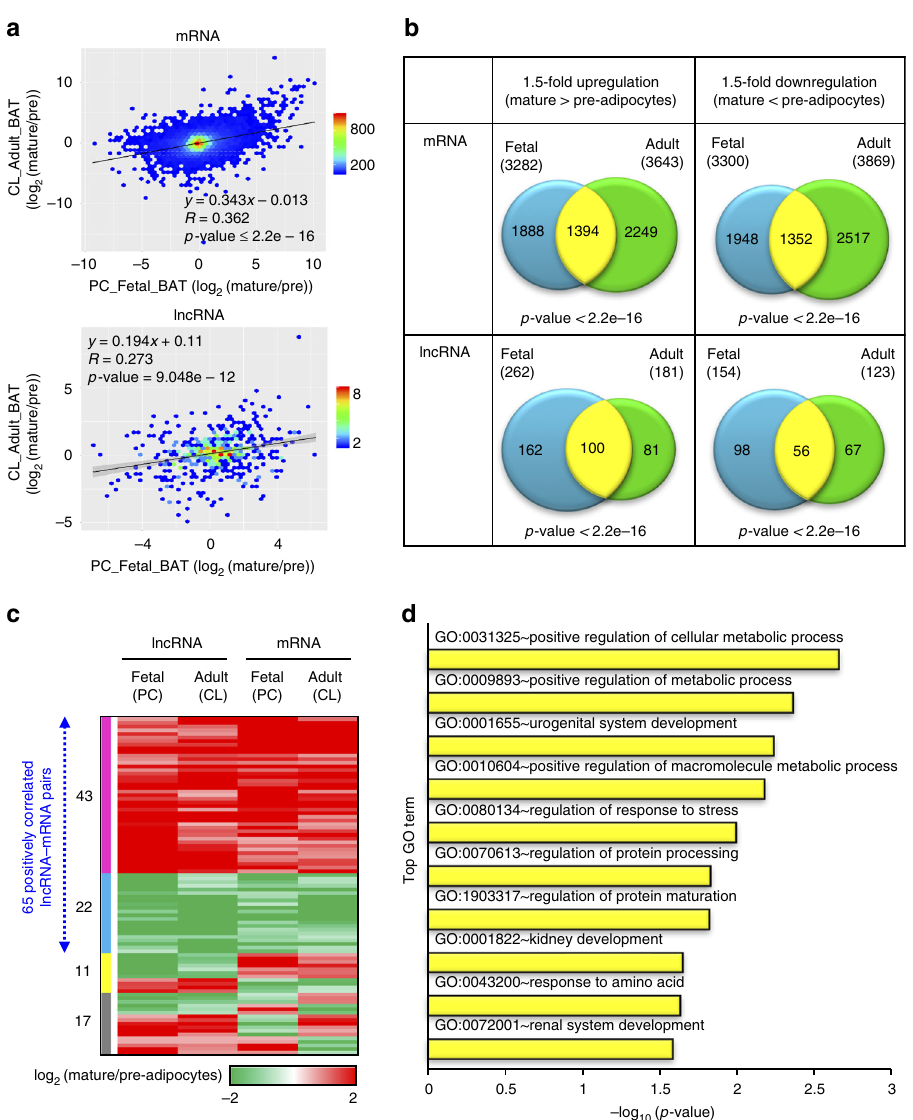
Fig. 3 Comparison of global expression changes between fetal and adult brown adipogenesis. a Hexbin plot of global gene expression changes for 14 487 mRNAs (top panel) and 586 lncRNAs (bottom panel) with detectable expressions during both fetal and adult BAT adipogenesis. Density of the data points is represented by color scales. PC primary cells, CL cell lines. b Venn diagram comparing fetal and adult BAT ’ s transcripts that are regulated (1.5-fold) during adipogenesis. mRNAs (top) and lncRNAs (bottom). c Heatmap depicting 93 lncRNA – mRNA pairs having at least 1.5-fold change between pre- adipocytes and mature adipocytes for both primary cells and cell lines. Pairs are grouped by the lncRNA – mRNA correlation status. Blue and magenta bars represent the lncRNA – mRNA pairs with coherent down- and upregulations during brown adipogenesis. Yellow bar represents the pairs for which the lncRNAs show anti-correlation with mRNA while gray bar represents the pairs, which show incoherent correlation. d Top 10 enriched gene ontology processes of the mRNAs in the upregulated lncRNA – mRNA pairs during both fetal and adult BAT adipogenesis (magenta category from c